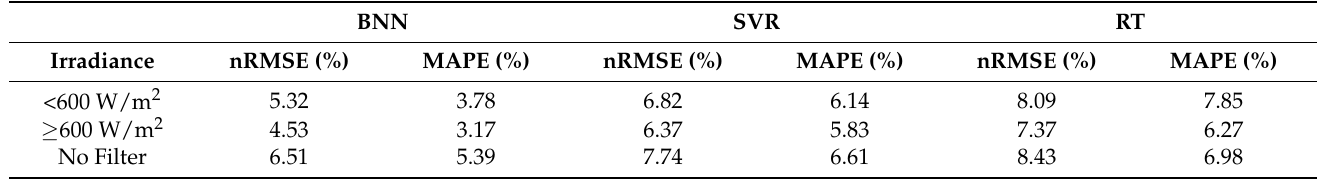
Table 5. Day-ahead photovoltaic (PV) production forecasting accuracy comparison of the machine learning predictive models trained at different irradiance condition levels, over the test set evaluation period.